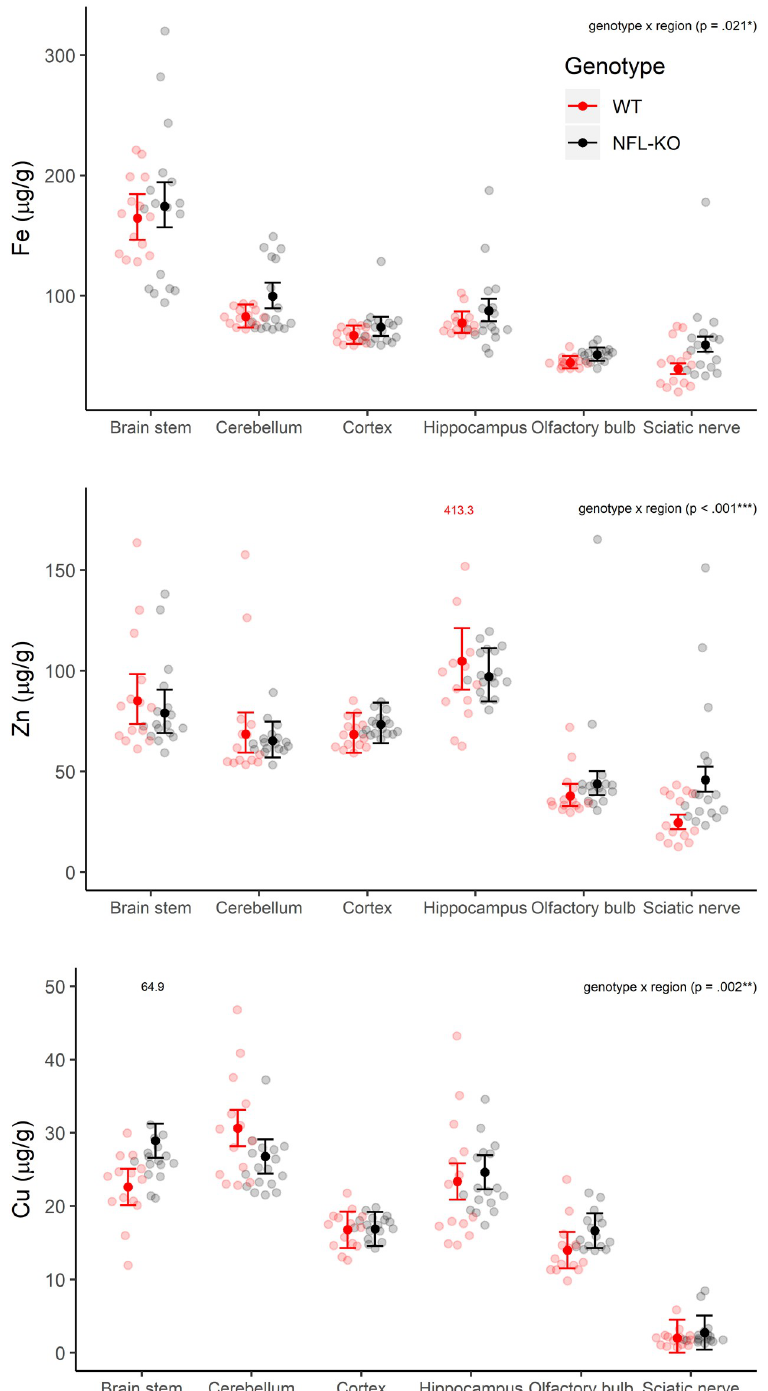
Fig 2. Metal variability in different brain regions. Estimated marginal means (and 95% CI) show patterns of Fe, Zn, and Cu composition in different brain regions for the two genotypes (WT and NFL-KO; averaged over 5mo and 22mo animals). There were significant genotype x region interactions for Zn, Fe and Cu (Zn: F (5, 140) = 8, p < .001; Fe: F (5, 140) = 3, p = .021; F (5, 139) = 4, p = .002).